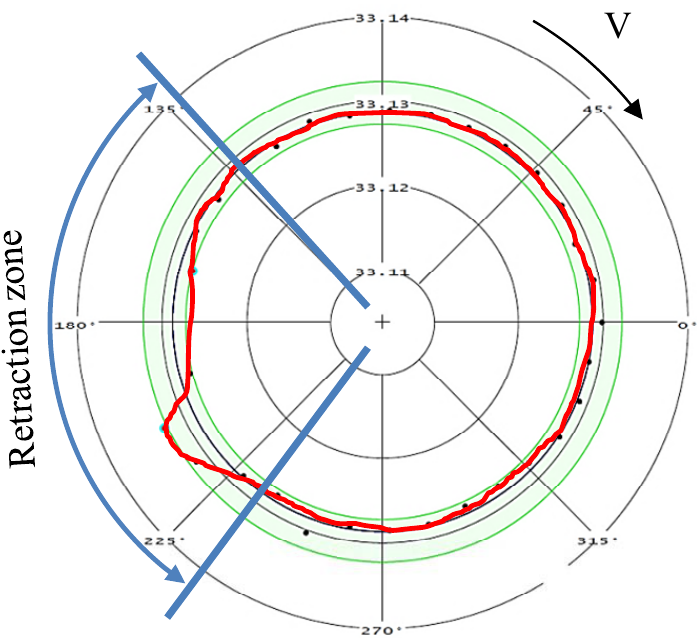
Figure 25. Circularity deviation of the machined workpiece for Trial